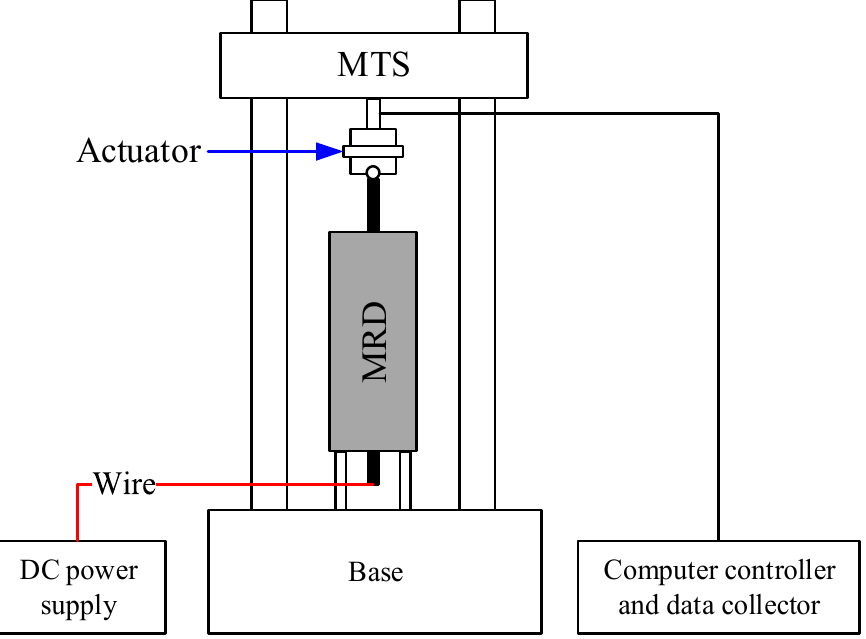
Figure 3. Schematic diagram of test loading equipment.